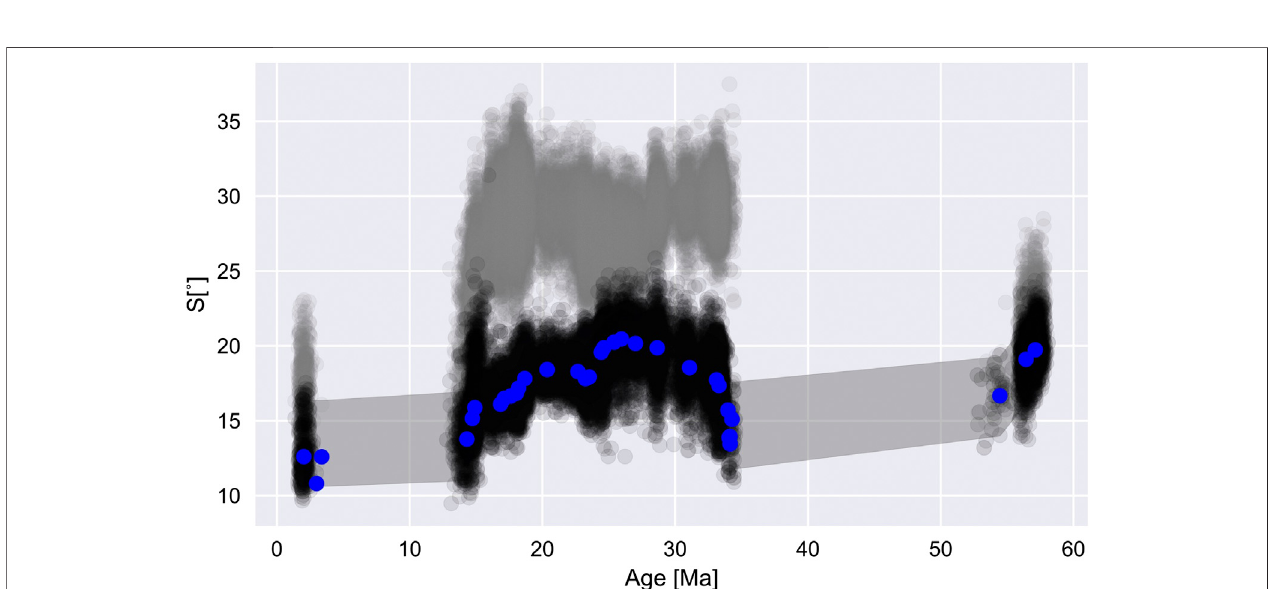
FIGURE9 | VGP scatter and 95%con fi dence limits with time for Australian Cenozoic paleomagnetic data(1,000 iterations). Black datawith indicate fi lteredvalues (Vandamme, 1994), with medians given by blue markers. Gray (un fi ltered values) are also shown. Marker transparency of 1% per iteration was used. A trend of decreasing VGP scatter with time is consistent with northward motion for Australia, and falls within expected values based on fi eld models (Tauxe and Kent, 2004) over this time interval.